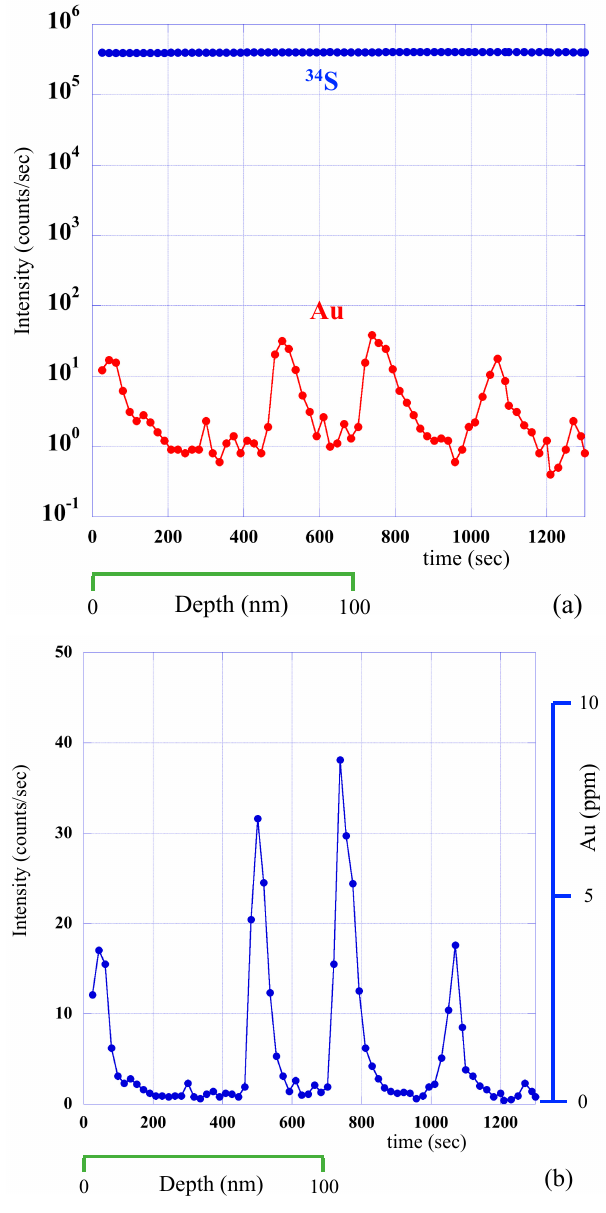
Figure A1. Depth profiles in pyrrhotite (34S_Au4*111.adp in Table A1) from the Kalahari Goldridge deposit. ( a ) Au and 34 S intensities (cps) on a logarithmic scale plotted against time. The corresponding depth is shown along the time scale. ( b ) Au intensity on a linear scale. The corresponding Au concentration is shown along the intensity scale. Several peaks corresponding to Au NPs (nanoparticles) are present in the profile.